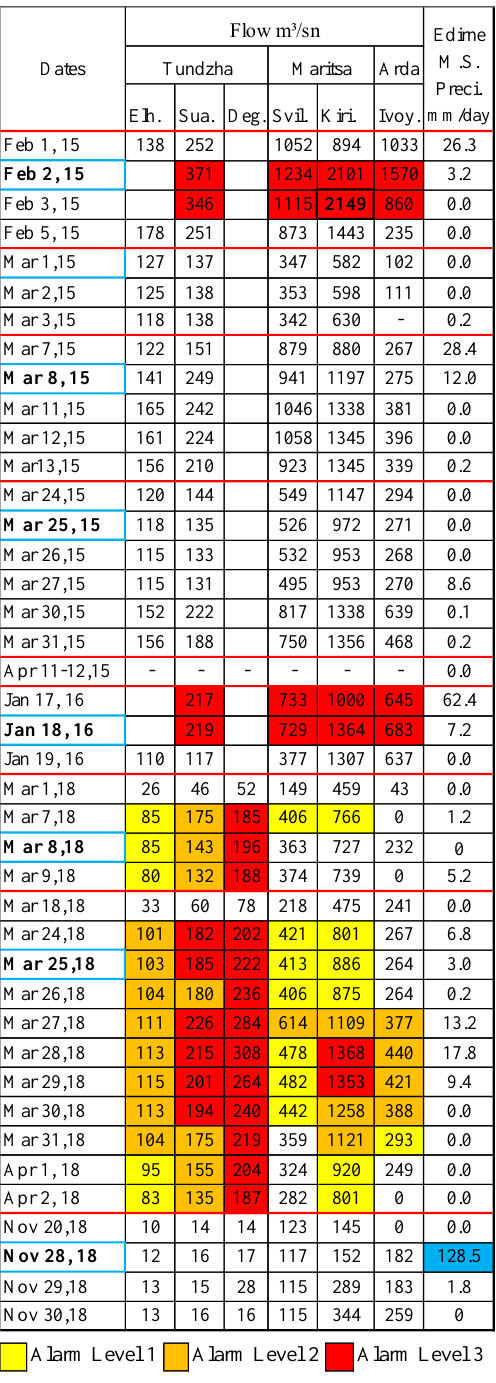
Table 3. Flows and precipitations